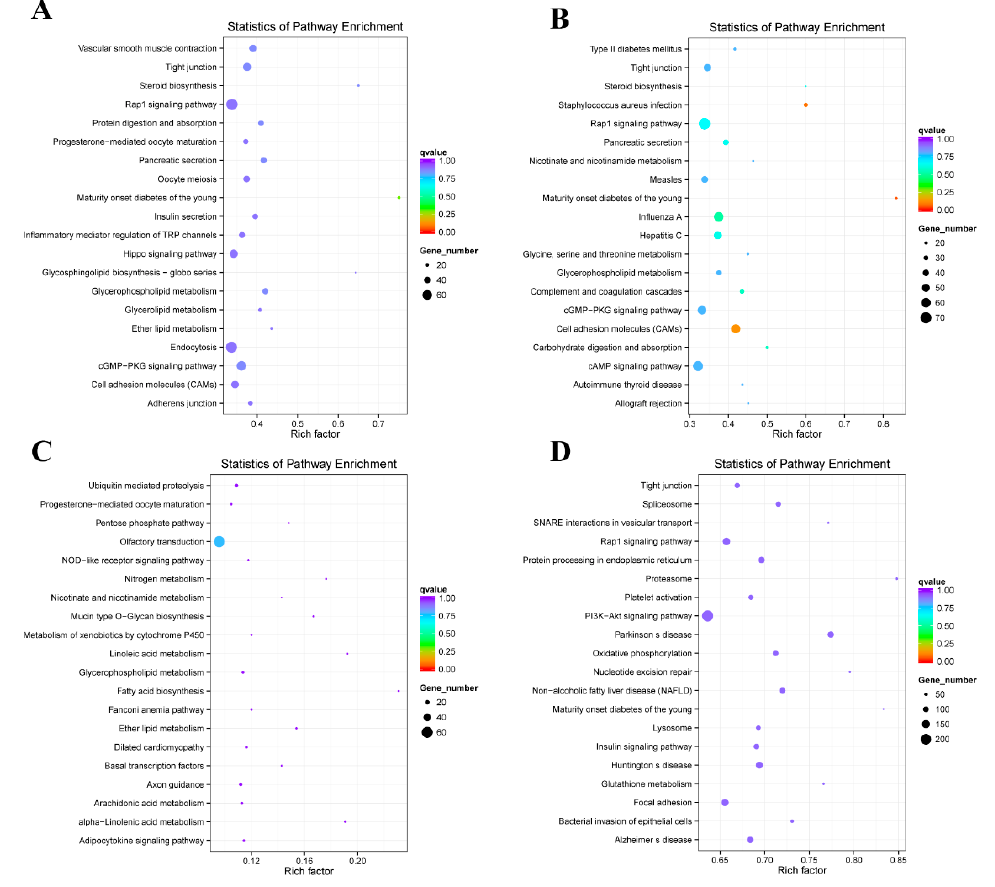
Figure 7. The KEGG analysis of co-expressed genes of differentially expressed lncRNAs. ( A ) The comparison of B vs S1. ( B ) The comparison of S1 vs S2. ( C ) The comparison of S2 vs S3. ( D ) The comparison of I vs S3.